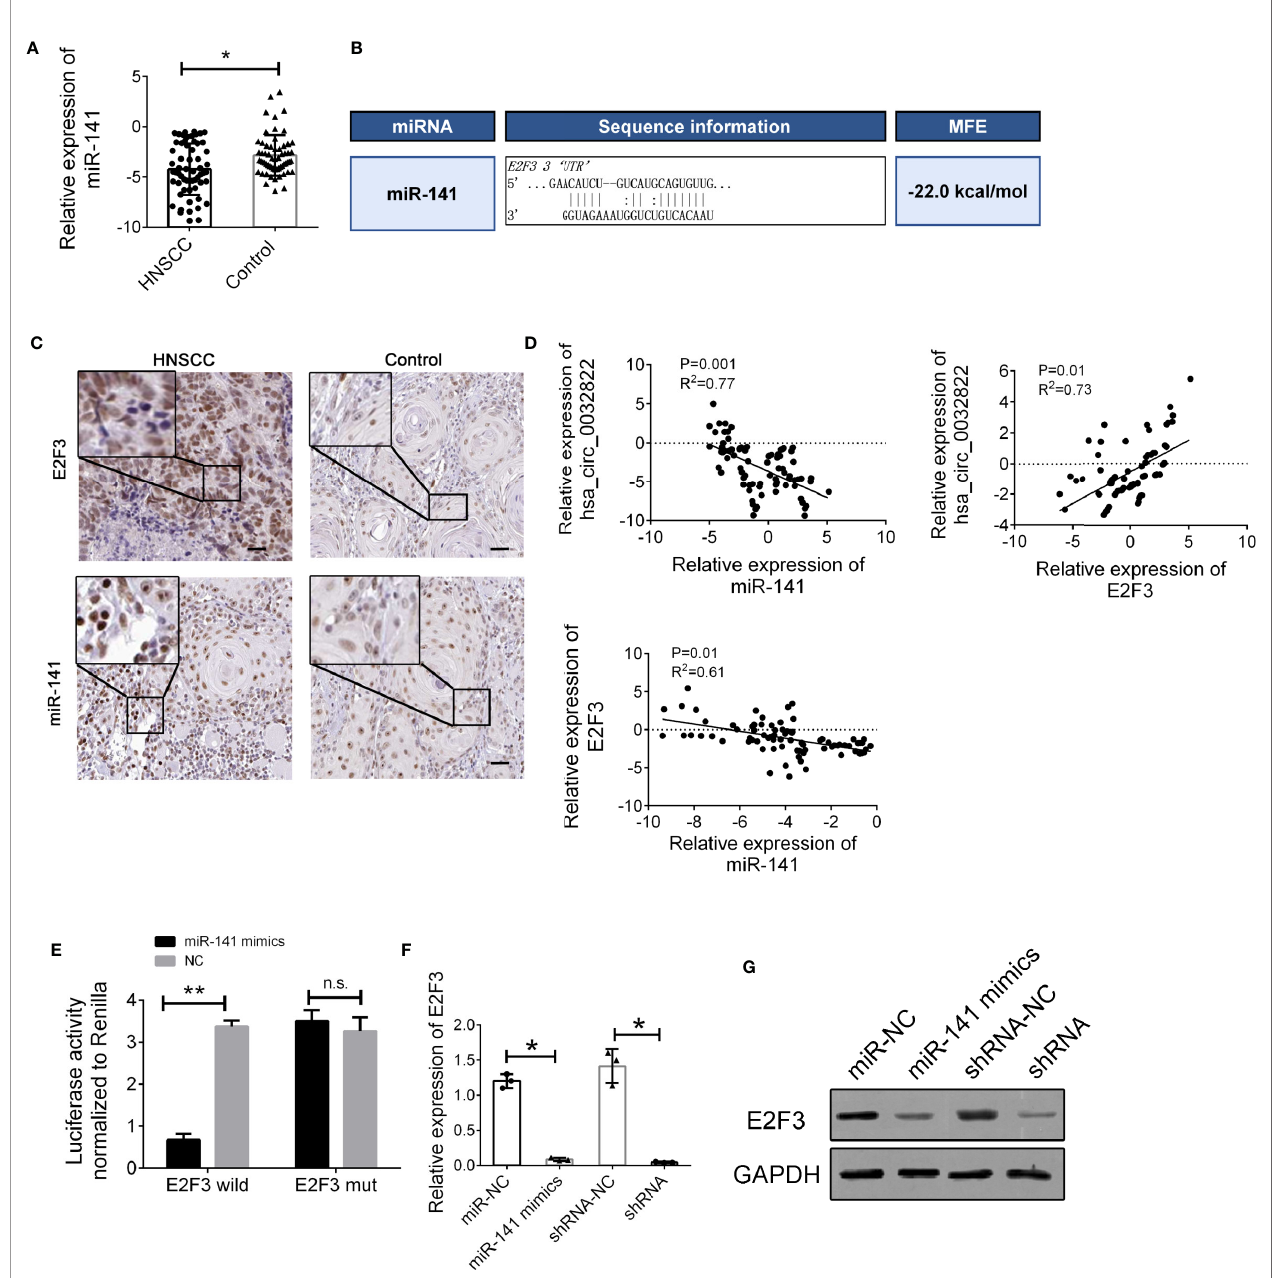
FIGURE 5 | miR-141 directly targeted E2F3. (A) Relative expression of miR-141 in tissues samples of HNSCC. (B) Detailed binding site for miR-141 and E2F3. (C) IHC stains of miR-141 and E2F3 in HNSCC tumor tissues. (D) Pearson correlation analysis for circ_0032822/miR-141/E2F3 in tissues. Data were presented as plot of the mean with SD with log-transformed. (E) Dual-luciferase reporter assay in cells treated with E2F3 3 ’ UTR and candidate miR-141 mimics. (F) mRNA expression of E2F3. (G) Protein expression of E2F3. Data were presented as plot of the mean with SEM. * indicated P < 0.05, ** indicated P < 0.01, n.s., no signi fi